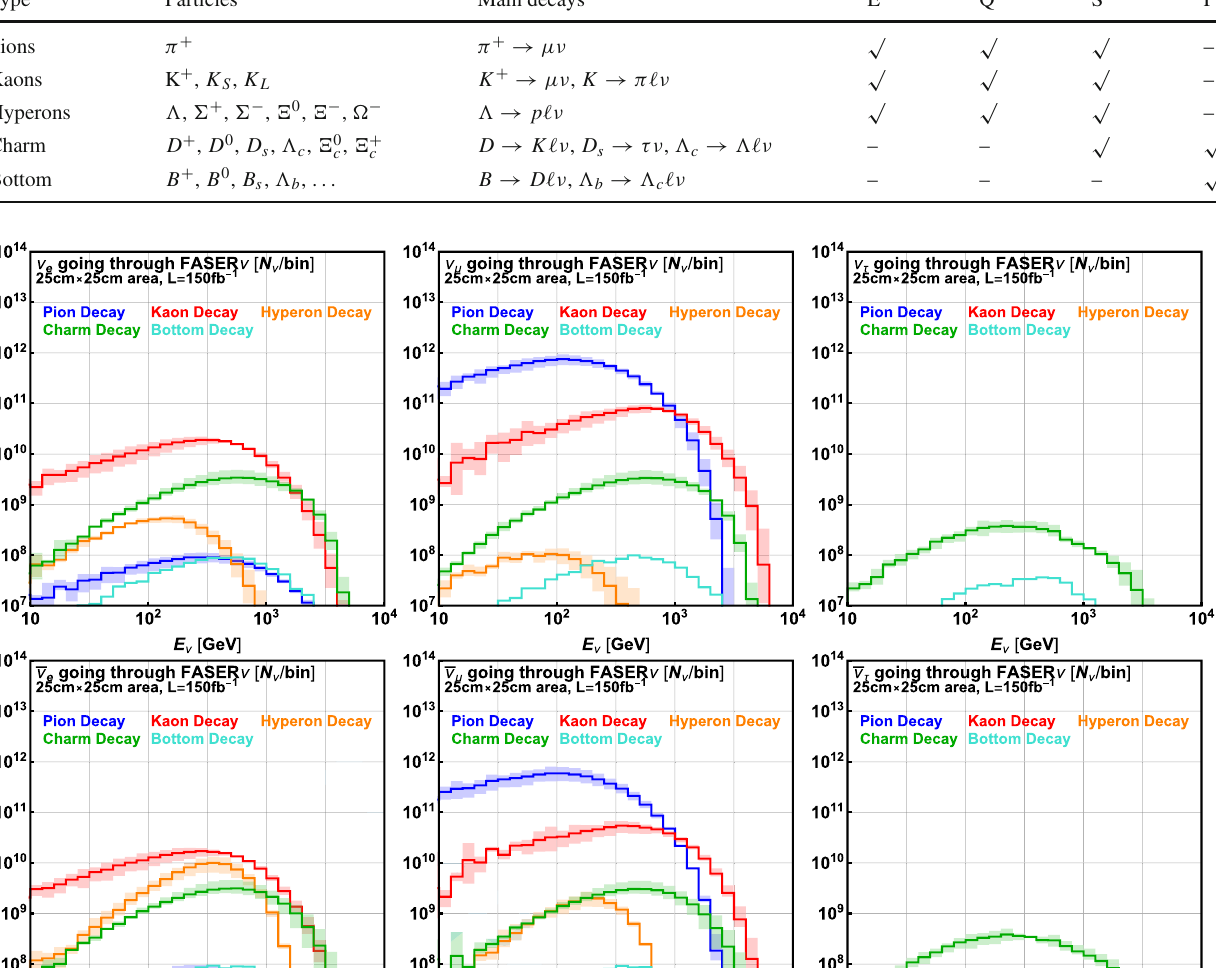
which generators were used to obtain the meson spectra: Epos- Lhc (E)